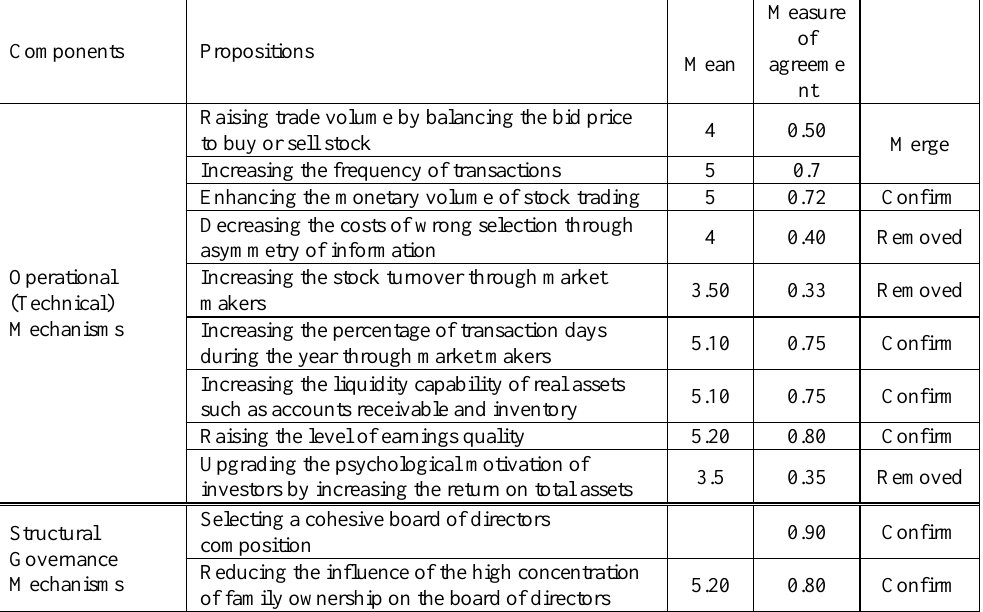
Table 5. The first round of Delphi analysis for the identified propositions